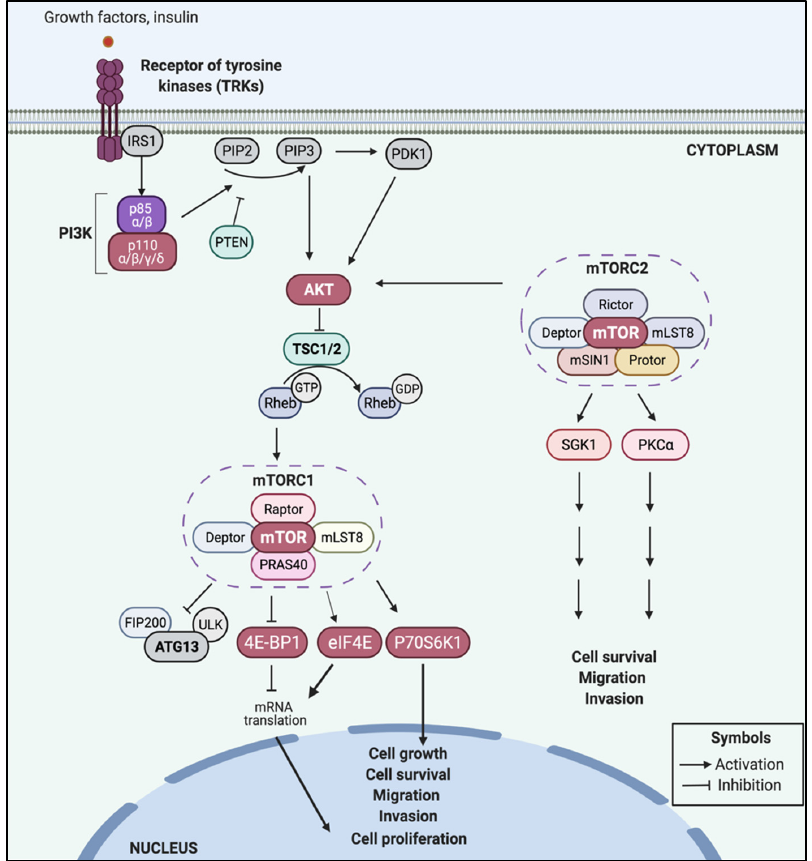
Figure 1. The canonical PI3K/AKT/mTOR pathway (created with Biorender).